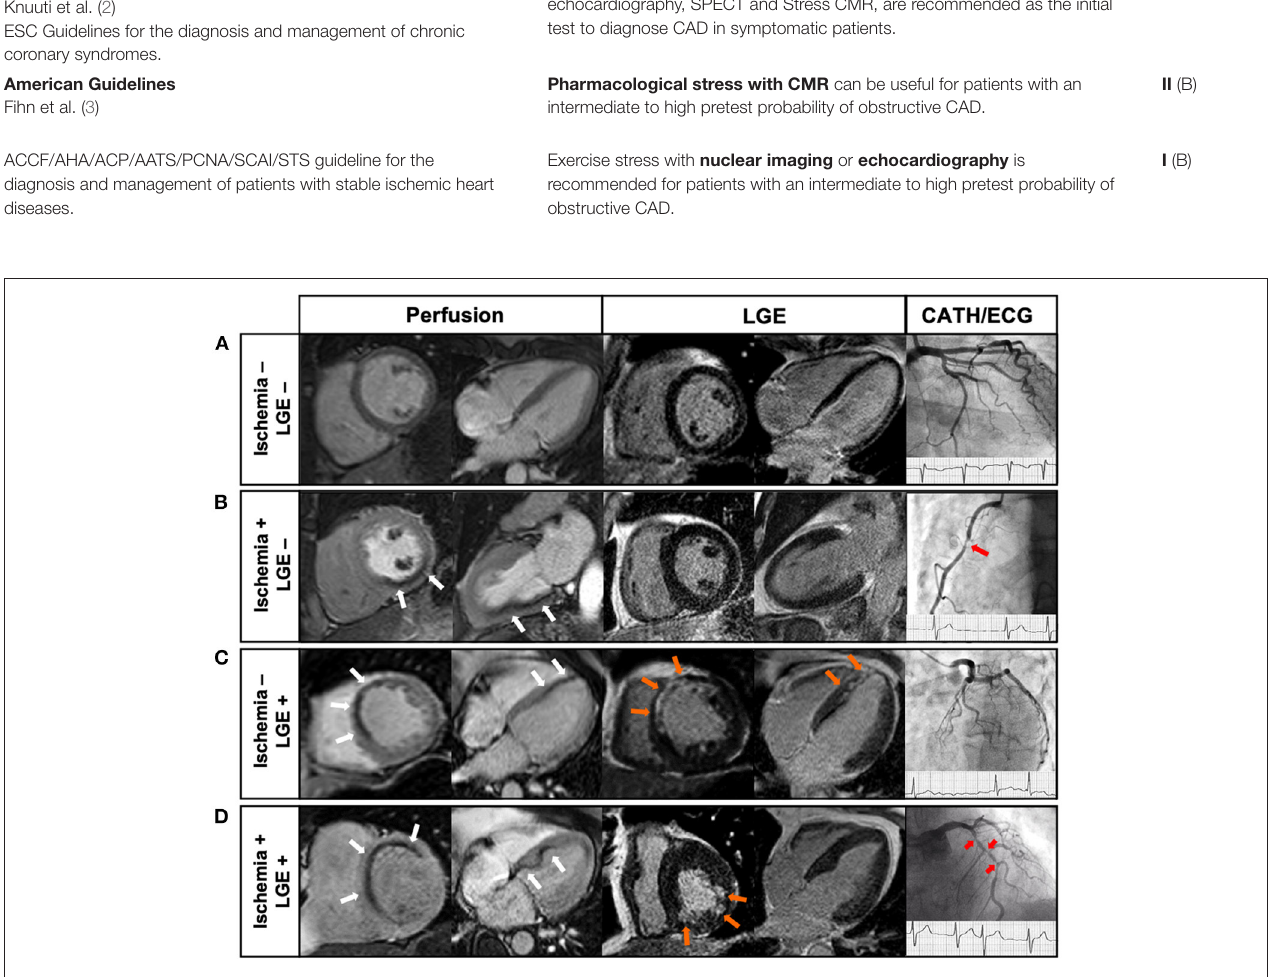
FIGURE 2 | Examples of Clinical cases of stress CMR (26). (A) 68-year old male with atypical chest pain. Stress CMR revealed no perfusion defect and LGE was negative, ruling out the diagnosis of CAD. (B) 71-year old male with dyspnea on exertion. First-pass myocardial stress perfusion images revealed a reversible perfusion defect of the inferior wall (3 segments) ( white arrows ) without LGE, indicative of myocardial ischemia suggestive of significant RCA stenosis, confirmed by coronary angiography ( red arrow ). (C) 62-year old female with prior anterior STEMI treated by PCI 4 years before, referred for atypical chest pain. CMR showed a subendocardial anteroseptal scar on LGE ( orange arrows ), with a colocalization of the perfusion defect ( white arrows ), and therefore no inducible ischemia. Coronary angiography confirmed the absence of significant stenosis. (D) 69-year old male with AF and a history of inferior NSTEMI treated by PCI 8 years before, presenting with dyspnea on exertion. CMR showed a subendocardial scar on the inferior wall on LGE sequences ( orange arrows ), and a perfusion defect of the antero-septo-basal wall (4 segments) ( white arrows ) on first-pass perfusion images, indicative of inducible myocardial ischemia. Coronary angiography showed several high-grade stenoses of the LAD ( red arrows ). CAD, coronary artery disease; CMR, cardiac magnetic resonance; LAD, left anterior descending; LGE, late gadolinium enhancement; MI, myocardial infarction; NSTEMI, non ST-segment elevation myocardial infarction; PCI, percutaneous coronary intervention; RCA, right coronary artery; STEMI, ST-segment elevation myocardial